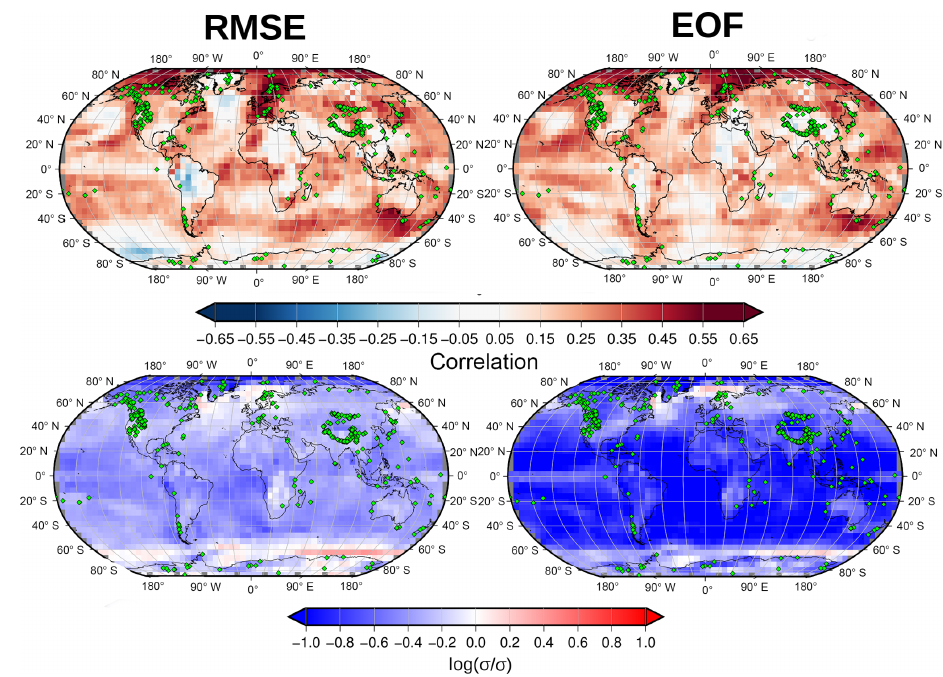
Figure 8. Similar to Figs. 5 and 6, but for a reconstruction of observations based on a calibration of proxies in the period 1911–1995. The correlation is calculated for the period